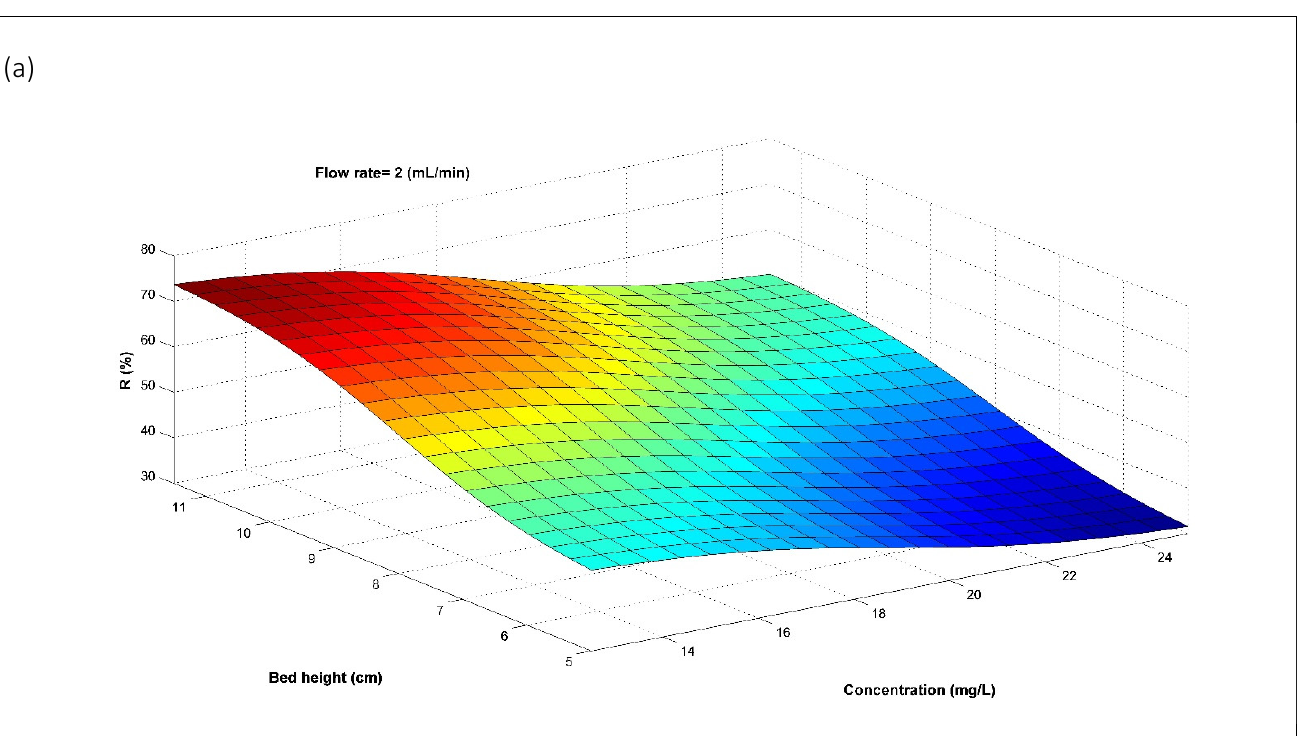
Table 6. Experimental and calculated values and relative error of the model for the metal retained percentage ( %R ) and biosorption capacity ( q e ).